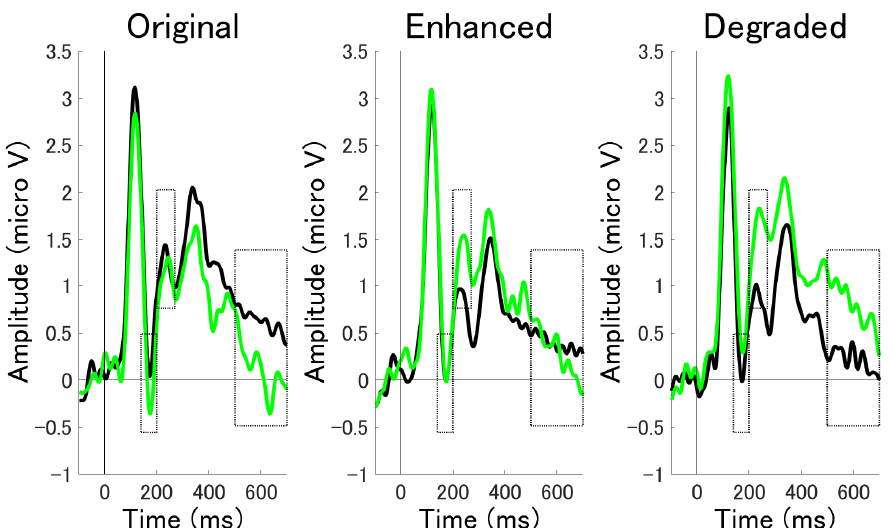
Figure 5. ERP waveforms recorded in each condition at right occipito-temporal electrode cluster. The black and green lines represent ERP waveforms for self and other familiar faces, respectively. The rectangles drawn by the dotted line represent time windows used for mean amplitude measurement of N170, P250 and LPC, respectively.